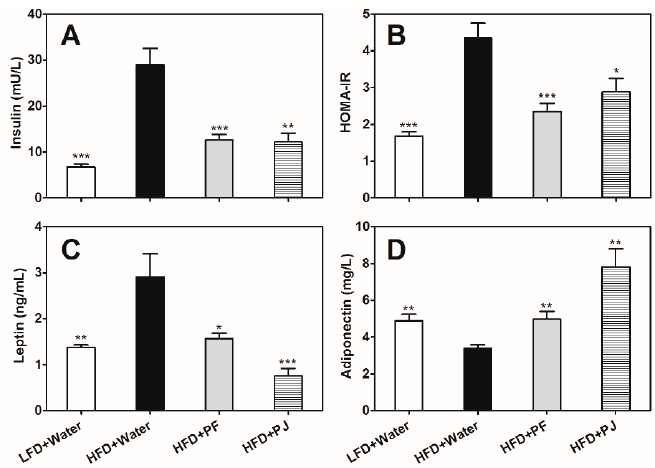
Figure 5. Effects of PF and PJ extracts on serum insulin ( A ); homeostasis model assessment of insulin resistance (HOMA-IR) ( B ); leptin ( C ); and adiponectin ( D ) in HFD C57BL/6 mice. Data are presented as mean ± SEM ( n = 6–10). * p < 0.05, ** p < 0.01, *** p < 0.001, compared to the HFD group treated with